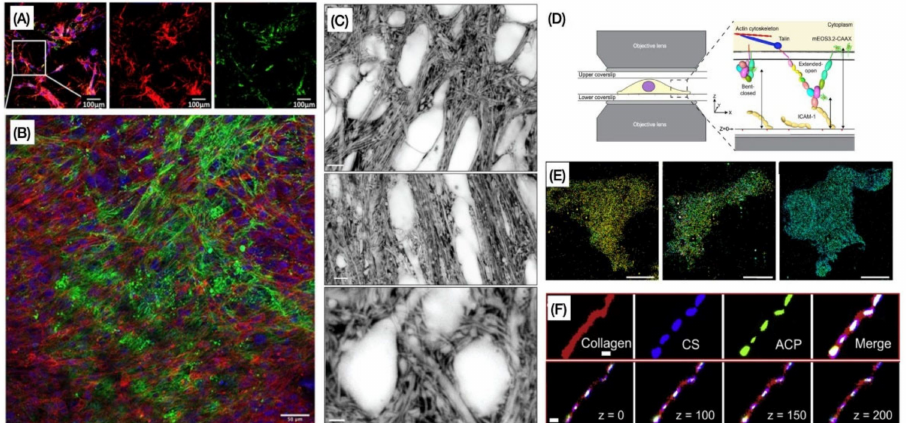
Figure 3. Representative images of different ECM components acquired by ( A ) WFFM, ( B ) LSCM, ( C ) STED/GSD, ( D , E ) PALM, and ( F ) STORM. ( A ) Shows a widefield fluorescence image of fibroblasts and matrix followed by images of Alexa-647-labeled fibronectin and antibody-stained collagen I alone. Scale bar, 100 µ m [48]. ( B ) Image obtained by confocal microscopy of fibronectin deposition and localization in 3D co-cultures of human breast cancer cells and human dermal fibroblasts. Cultures were labelled to visualize actin (red), fibronectin (green), and cell nuclei (blue). Scale bar, 50 µ m [49]. ( C ) Higher magnification SUSHI (super-resolution shadow imaging) images of cell bodies and neuropil in CA1 area. Scale bar in top, 4 mm; middle, 5 mm; bottom, 2 mm [50]. ( D ) Schematic of sample setup for iPALM imaging of migratory Jurkat T-lymphocytes adhered to ICAM-1 or fibronectin-coated lower coverslips, with gold nanorod fiducial markers (orange spheres) [51]. ( E ) Representative iPALM renderings of Jurkat cells expressing mEOS3.2-LFA-1 fusion, mEOS3.2-CAAX, or LifeAct-mEos3.2. Scale bars, 5 mm [52]. ( F ) STORM images of mineralized collagen fibrils at an early stage (top). Representative Z-dimension slices of the STORM images (bottom). Amorphous calcium phosphate (ACP) preferentially aggregates around purple in the intrafibrillar compartments, which represent chondroitin sulfate (CS) in CS-collagen fibril. Scale bar: 500 nm [52]. Images reproduced with permission from